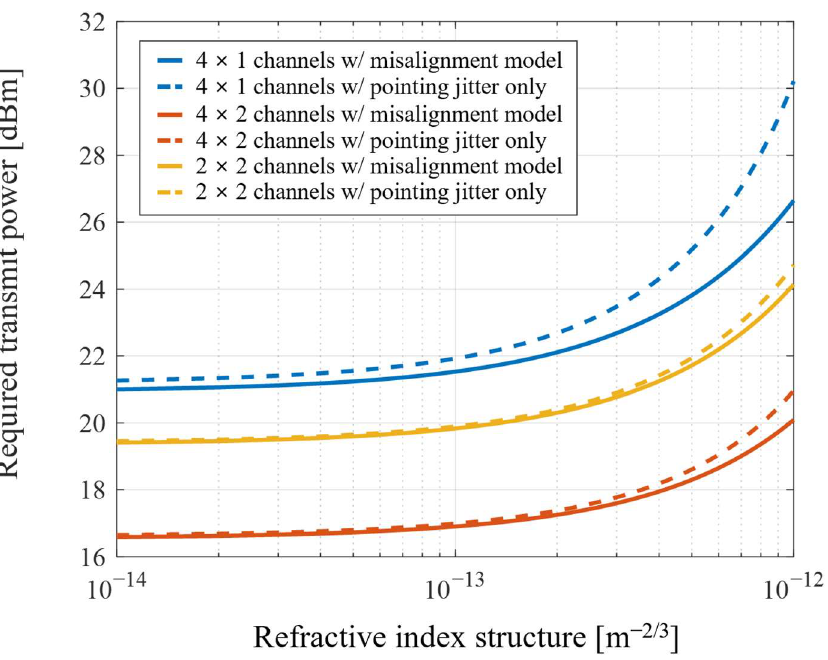
Figure 3. Required transmit power for the different number of channels.